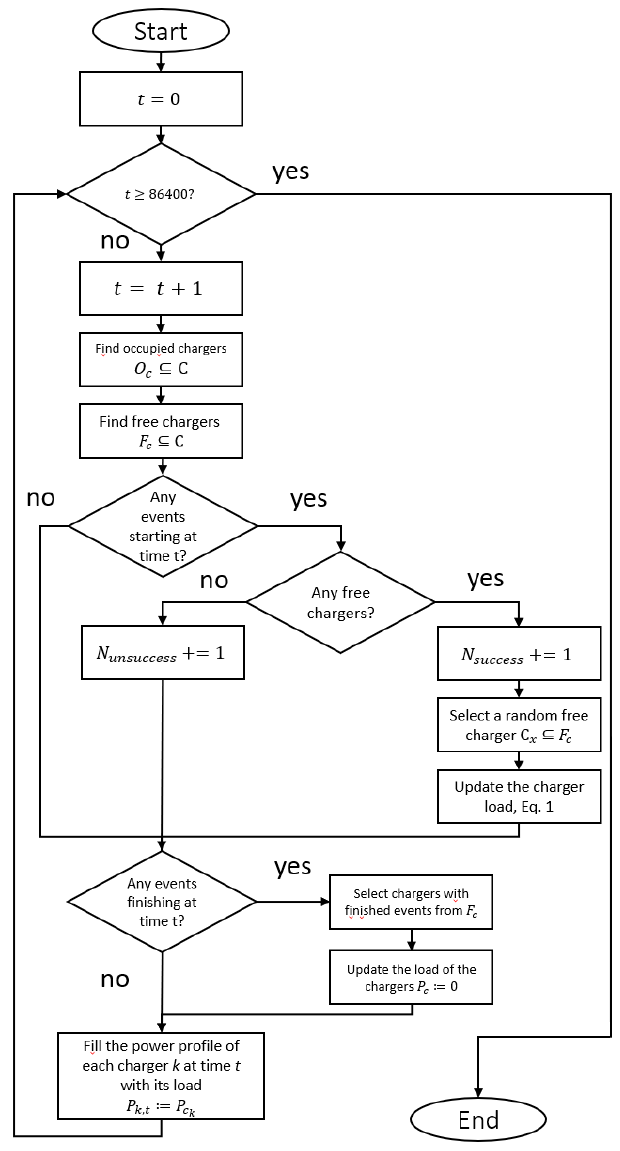
Figure 5. Schematic representation of the simulation